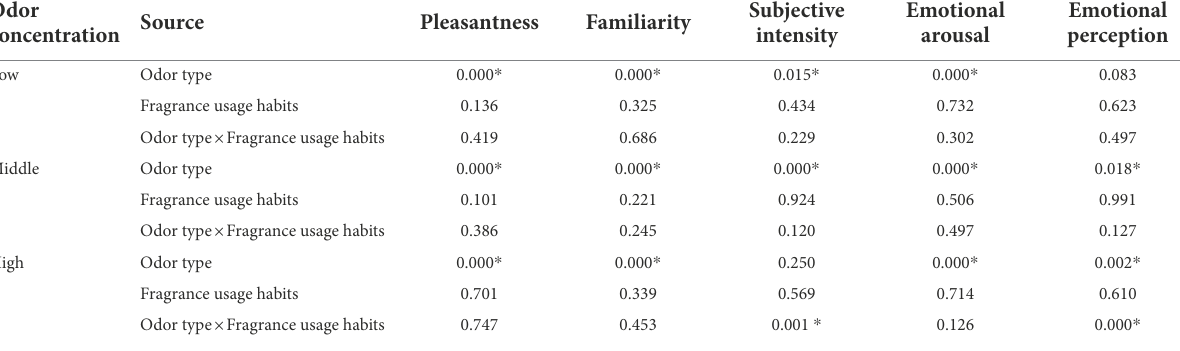
TABLE 9 The significances of the indicators under main effect and interaction of habits and type. Odor Source concentration